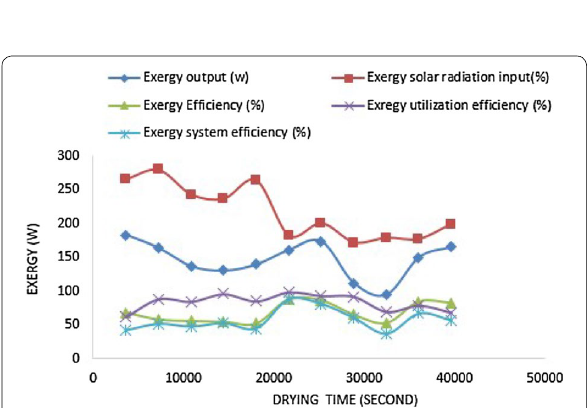
Fig. 16 Variation of efficiency as a function of drying time and exergy in the drying chamber (3rd day) tomato